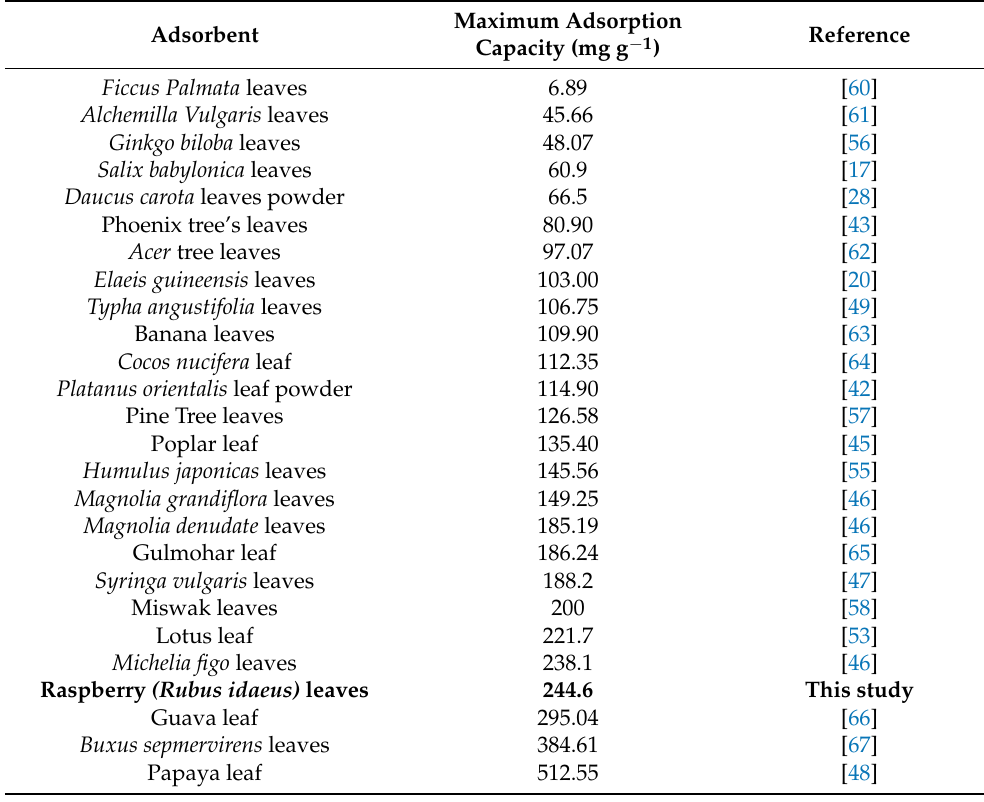
Figure 7. The fitted Sips isotherm curves at different temperatures. Table 3. The maximum adsorption capacities for different adsorbent materials based on plant